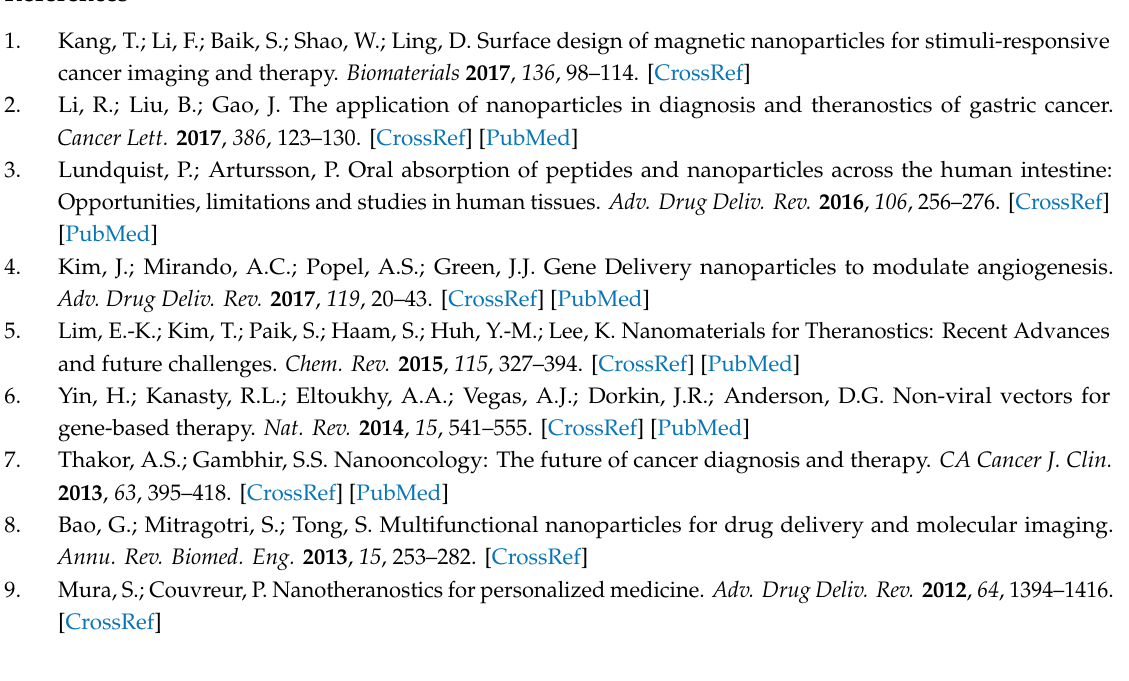
Figure S1: TEM images of coated SPIONs: (a) B1.1, (b) B2.2., Figure S2: XRD di ff ractograms and Mössbauer spectra of coated SPIONs (Samples B): (a) B 1.1, (b) B 2.2., Figure S3: Saturation magnetization curves at 300 K (a) and 10 K (b) of coated SPIONs (Samples